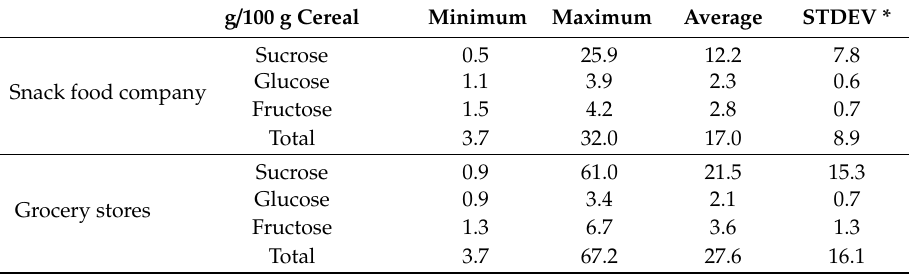
Table 1. Individual and total sugar content for industry-provided and purchased breakfast cereal samples measured by high-performance liquid chromatography